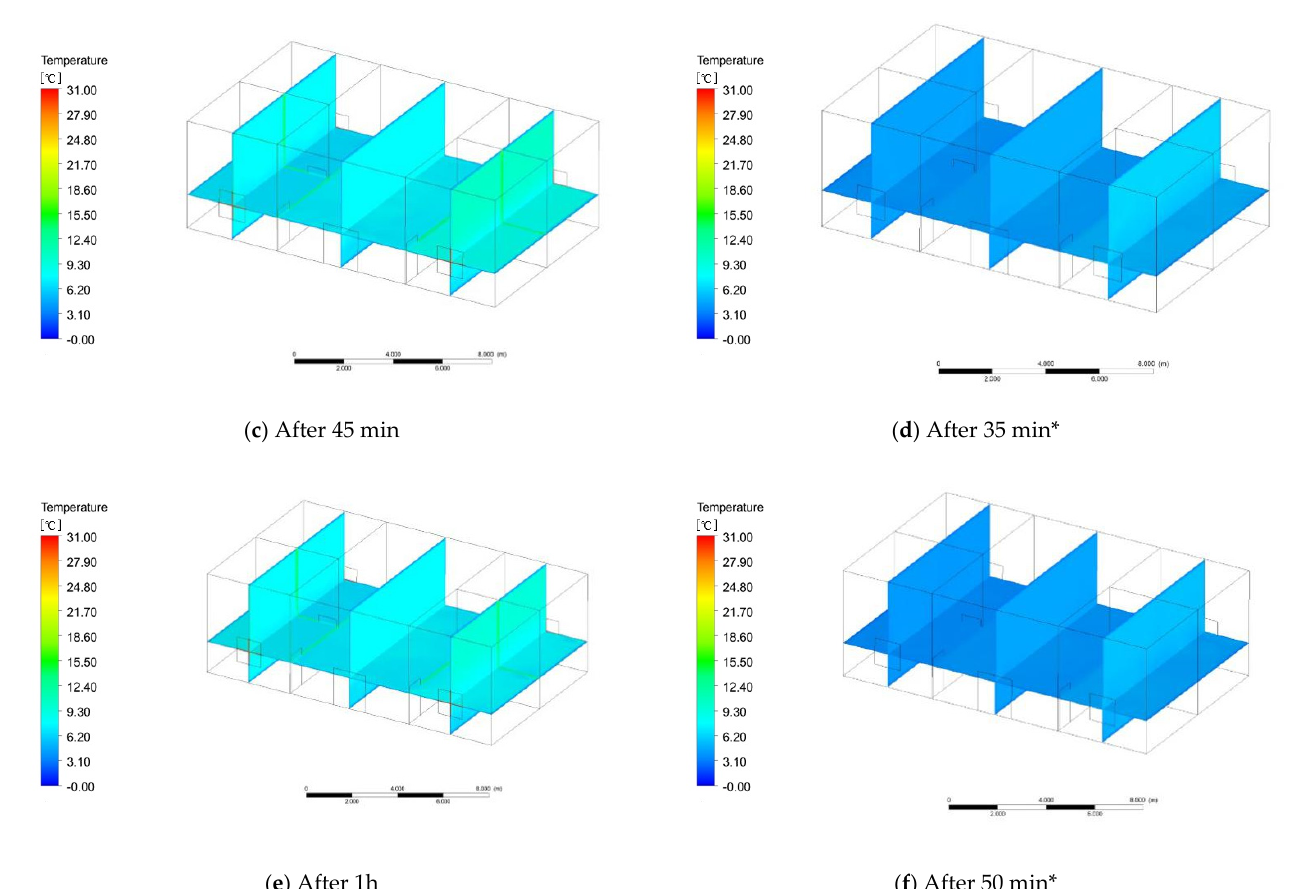
Figure 12. Temperature after the heating system was powered off; * refers to heating without solar radiation.